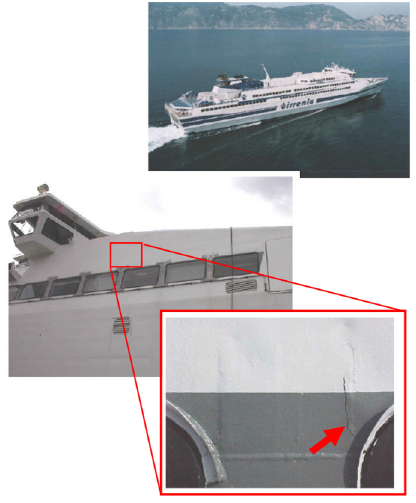
Figure 1. Fatigue cracks in ship structures.